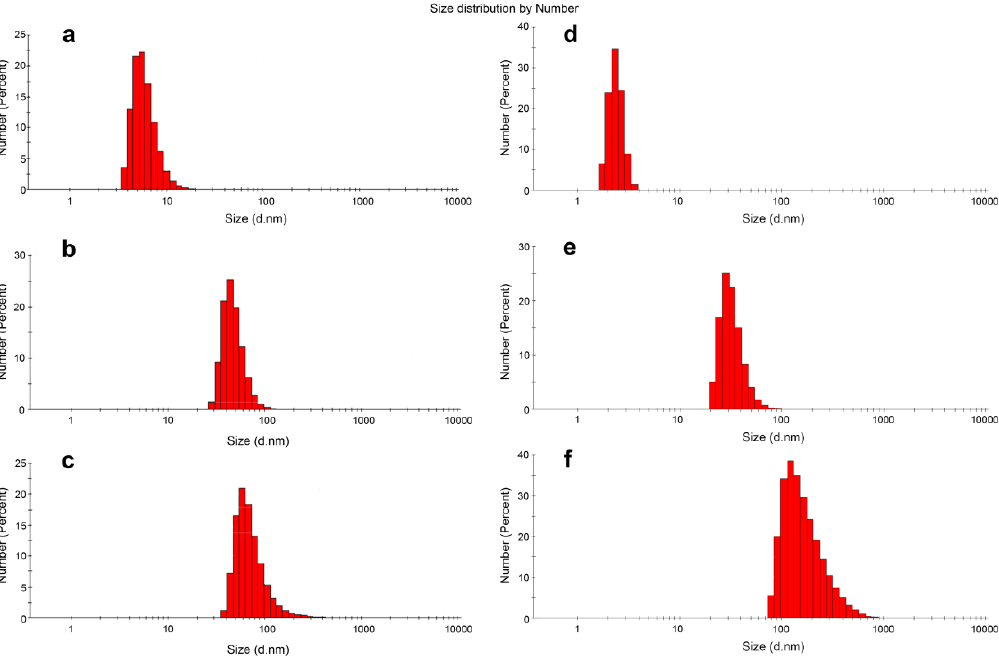
Figure 2. Size distributions of the control oligonucleotides 13 ( a ), 17 ( d ) compared with D-13 ( b ), D-13 PG ( c ), D-17 PG ( e ) and D-17 PG ( f ) conjugates (after 3 h incubation at 5 µM in TAM buffer) as measured by DLS. The D-13 PG dodecyl oligonucleotide conjugate with two uncharged PG groups